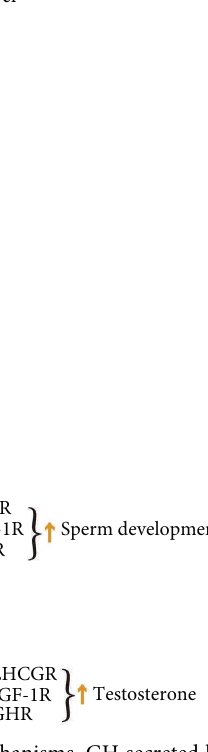
Figure 1: GH/IGF-1 roles in reproduction of adult males and potential mechanisms. GH secreted by the anterior pituitary, which is the main source of systemic GH, induces the liver to produce IGF-1. Systemic GH/IGF-1 reaches the testis and improves the production of local GH/IGF-1. In response to systemic GH/IGF-1 and/or local GH/IGF-1, FSH action on the Sertoli cell is improved to ameliorate the sperm development environment, and LH action on the Leydig cell is promoted to increase the levels of T. Te efect of GH/IGF-1 on sper- matogenesis is not clear and is not shown in the fgure. GHR: growth hormone receptor; IGF-1R: insulin-like growth factor-1 receptor; LHCGR: luteinizing hormone/choriogonadotropin receptor; FSHR: follicle-stimulating hormone